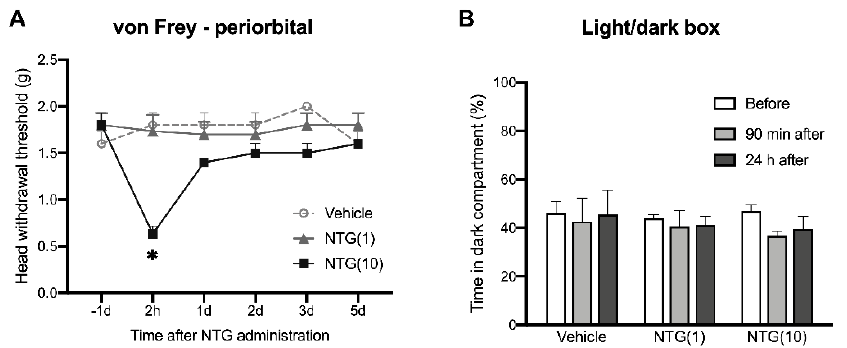
Figure 2. Systemic injection of NTG induces acute migraine-like hypersensitivity in mice. ( A ) Intraperitoneal injection (i.p.) of NTG at 10 mg / kg decreased the head withdrawal threshold in the periorbital region, whereas 1 mg / kg of NTG had no e ff ect on the threshold ( n = 6 per group). F treatment (2, 14) = 6.394, p < 0.05; F time (5, 70) = 2.886, p < 0.05; F interaction (10, 70) = 4.189, p < 0.001. * p < 0.05 vs. the corresponding time point in vehicle group. ( B ) Both vehicle and NTG did not significantly alter the time spent in the dark compartment ( n = 6–9 per group). NTG: nitroglycerin; NTG(1): 1 mg / kg of nitroglycerin; NTG(10): 10 mg / kg of